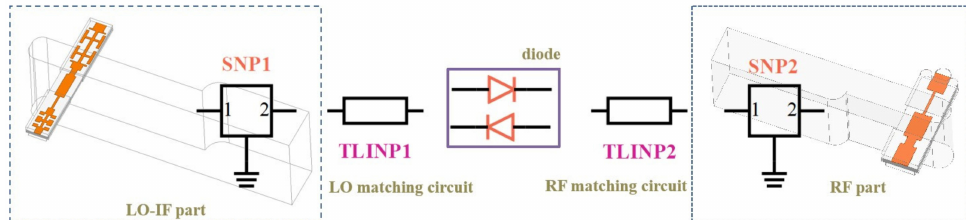
Figure 1. The active circuit model of mixers combining single stage reduced matching technology with the SDM.